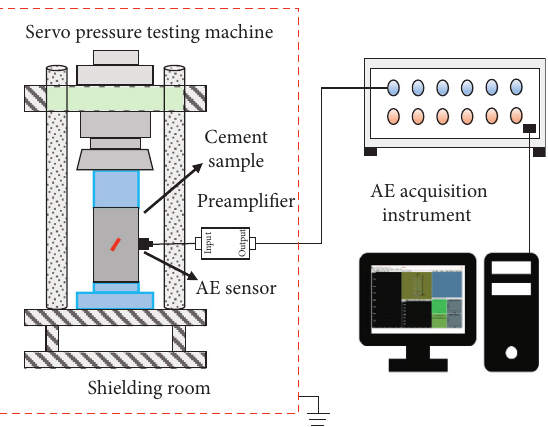
Shielding Figure 2: Schematic diagram of the experimental